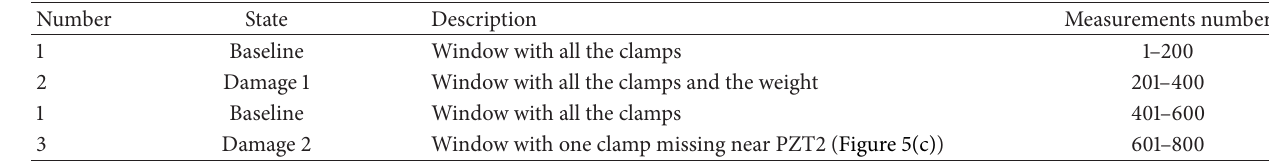
Table 5: States of the aircraft window.